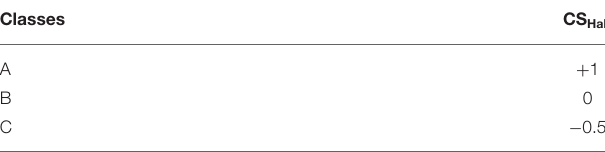
TABLE 3 | Determination of the backwater penalty based on the distance of the compartment to the impoundment’s embankment (A, B, and C) and its situation within the morphological floodplain (active and former